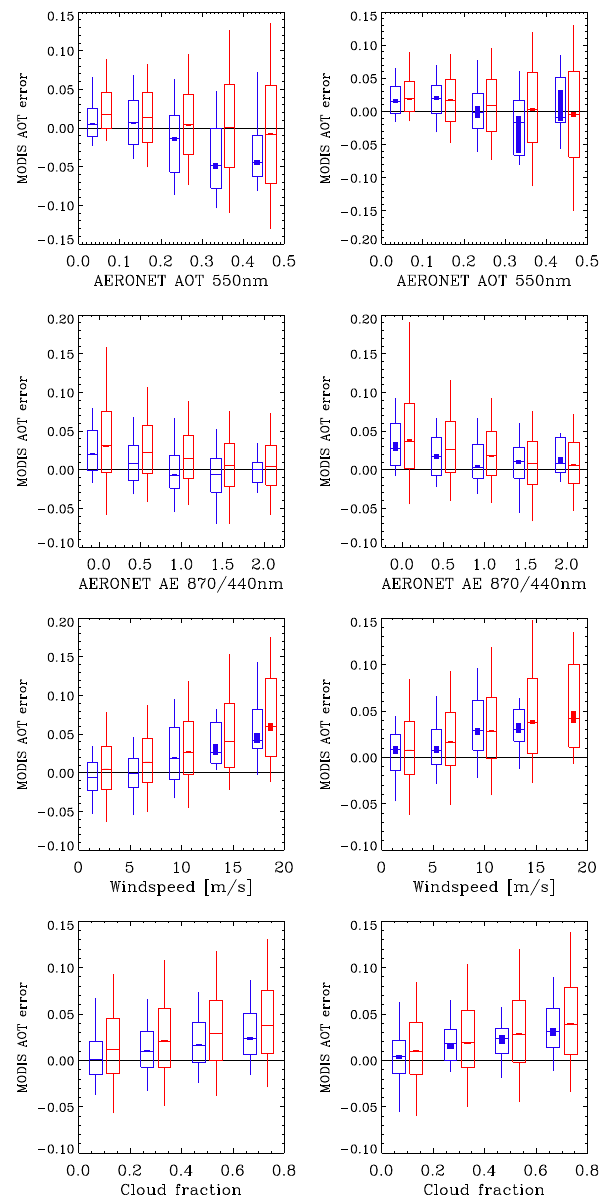
Fig. 6. Terra AOT error statistics against the Maritime Aerosol Net- work (blue) or AERONET for either the full dataset (left column) or independent sub-samples (right column). When using independent sub-samples, Maritime Aerosol Network and AERONET data yield very similar MODIS biases.